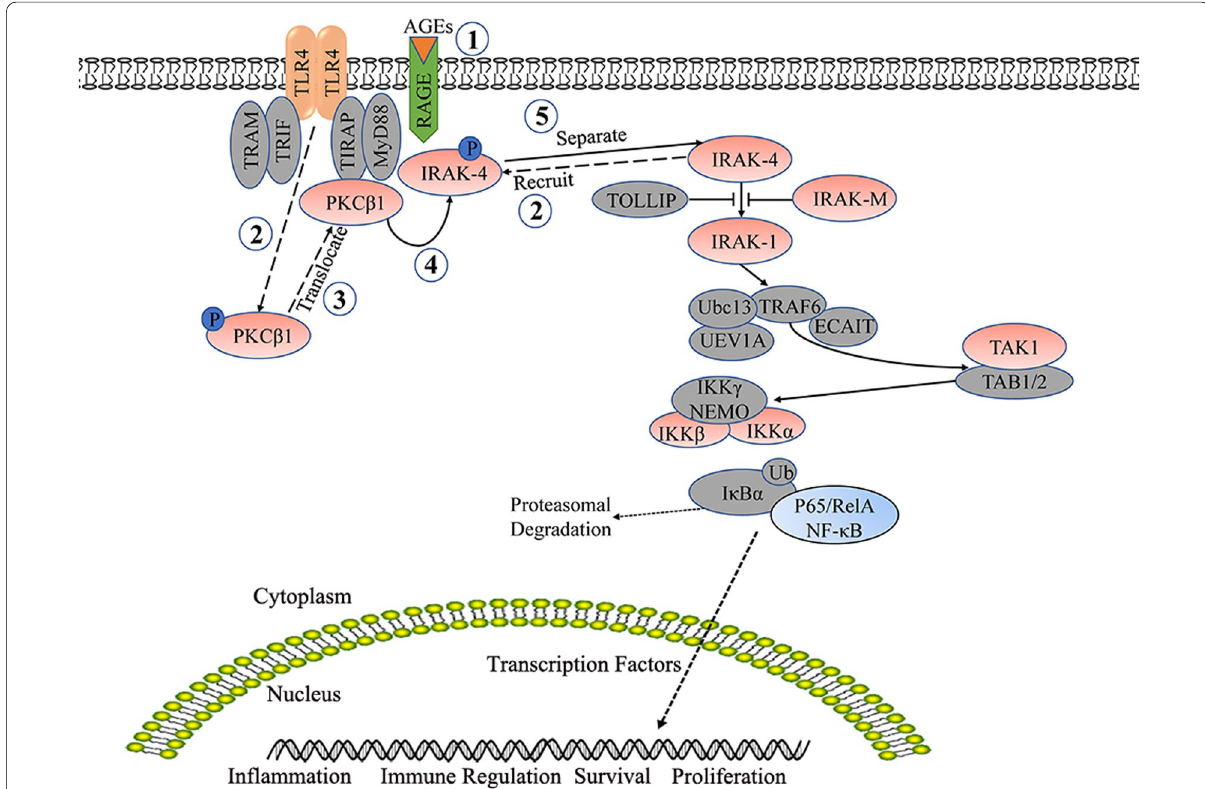
Fig. 7 RAGE-TLR4-pPKCβ 1 signal pathway diagram. After AGEs was combined with RAGE, the expression of RAGE was up-regulated and PKCβ 1 was activated together with TLR4, phosphorylated PKCβ1 was transferred from the cytoplasm to the membrane, and formed RAGE-TLR4-pPKCβ 1 complex, then activated the TLR4 signaling pathway through the phosphorylation of IRAK4, which promoted the phosphorylation of NF-κB, and further promoted the immune maturation of dendritic cells and the expression of inflammatory